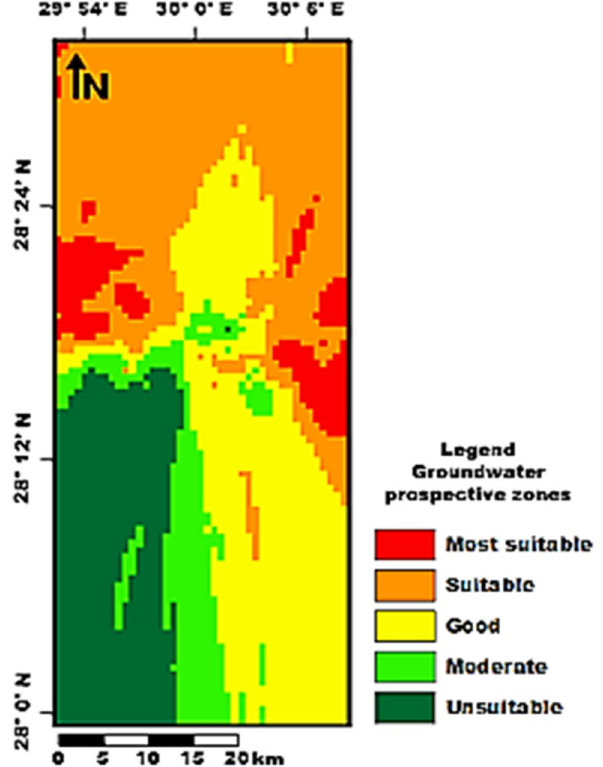
Fig. 19 Prospective groundwater